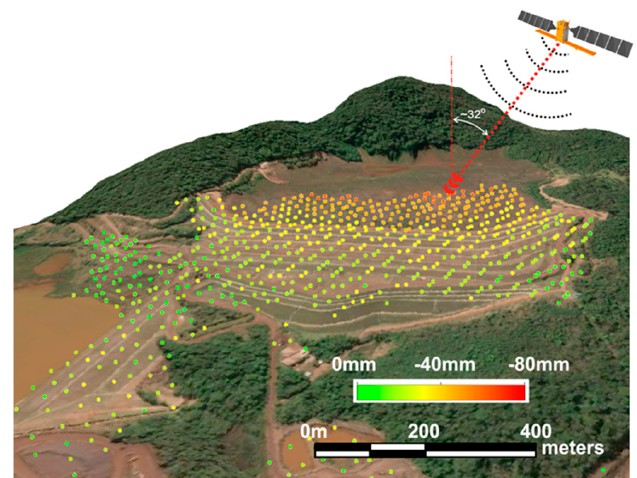
Figure 6. 3D view of Dam-I showing the accumulated displacement from SBAS processing analysis represented by colored dots.